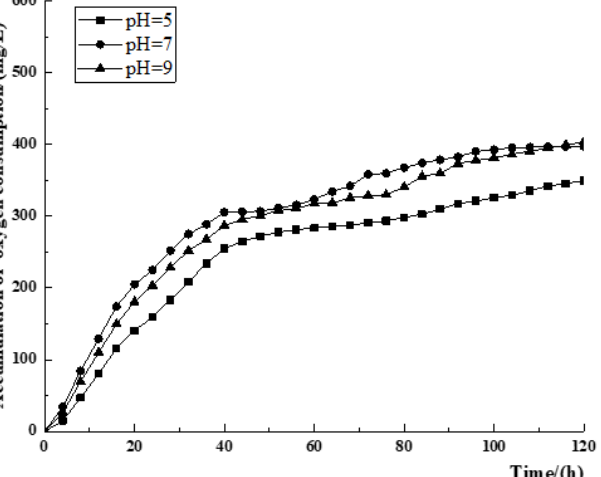
Figure A2. Accumulation of oxygen consumption under different pH conditions.